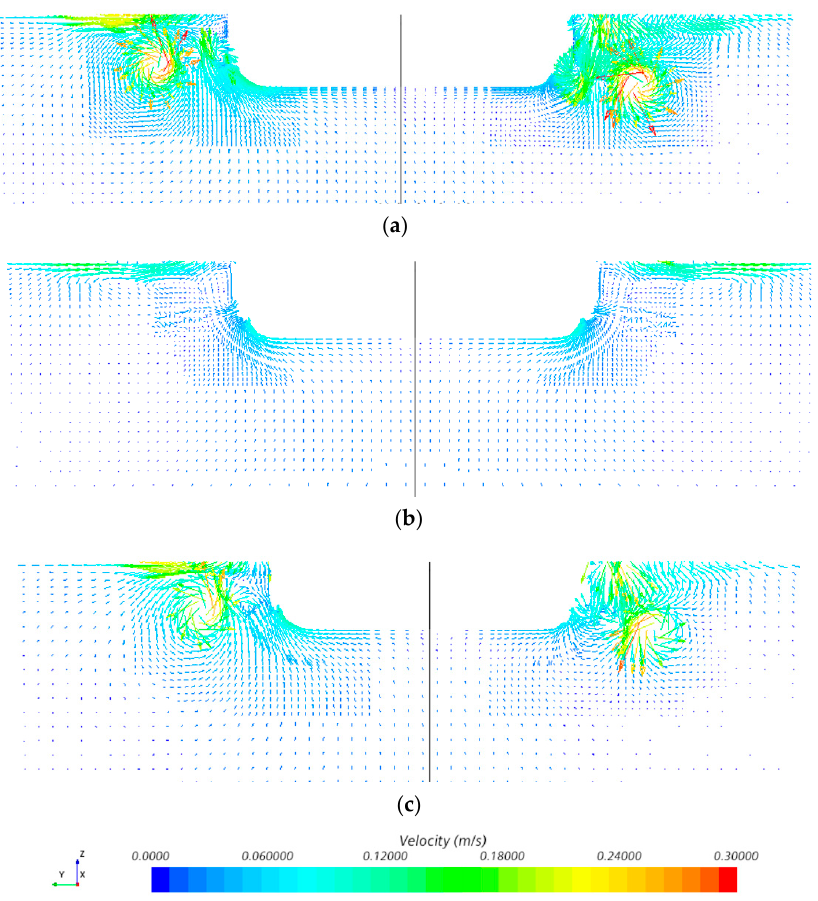
Figure 19. The circumferential velocity distribution comparison at 18 kn. ( a ) Without fin. ( b ) With 0° fin. ( c ) With 20° fins.